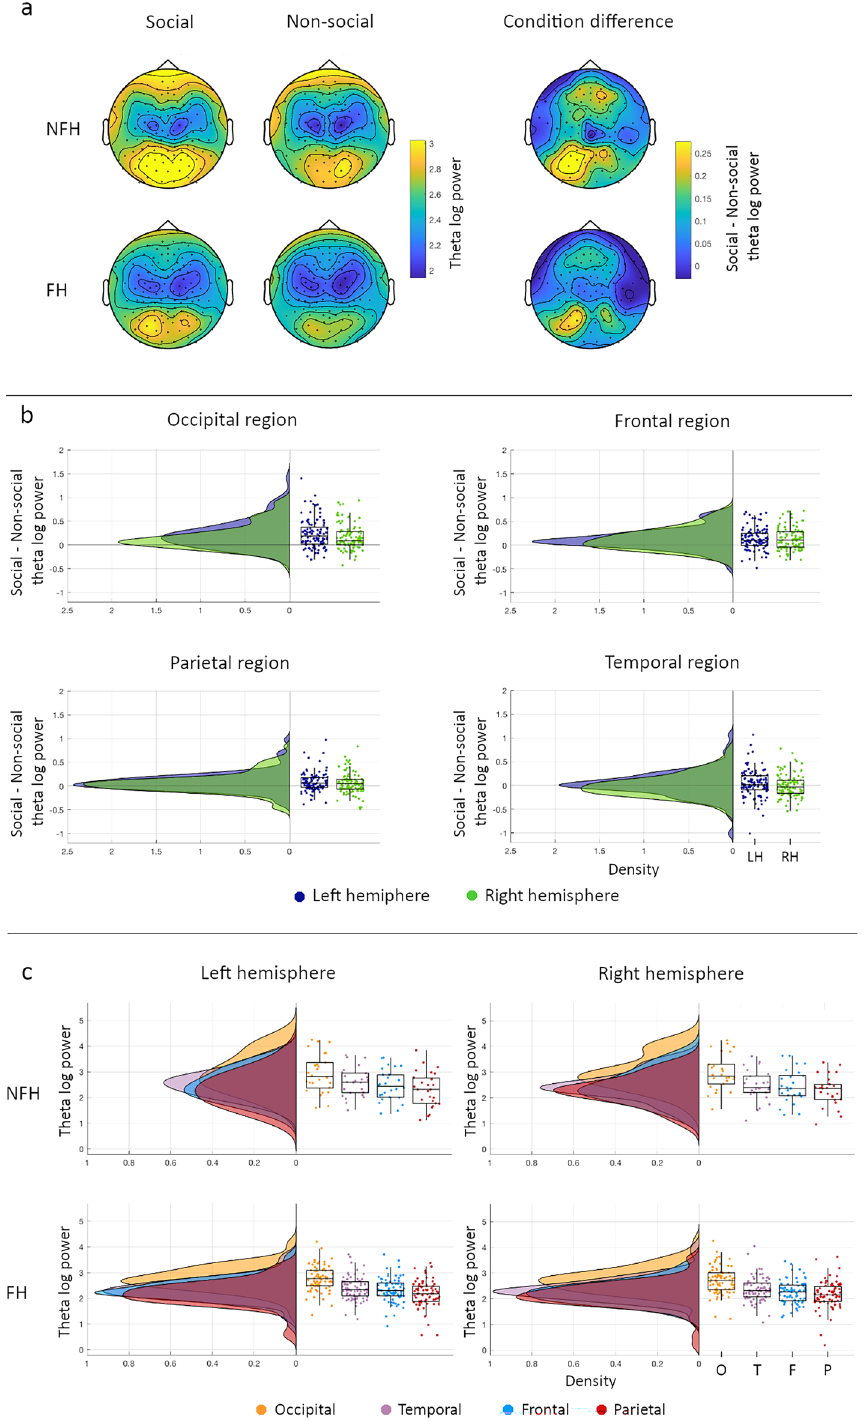
Figure 2. Theta power modulations by social context. ( a ) Topoplots for the social and non-social condition (left and middle) and the difference (social–non-social) between conditions (right) for the NFH (top) and FH (bottom) group. ( b ) Density and boxplots for condition differences in power for the left (LH in navy) and right (RH in green) hemisphere in for each region (occipital in top left, frontal in top right, parietal in bottom left, and temporal in bottom right plot). Each dot represents 1 infant. Positive values indicate higher power for social than the non-social condition. ( c ) Density and boxplots for power within each region (occipital (O) in yellow, Temporal (T) in purple, Frontal (F) in blue, and Parietal (P) in red) within the left hemisphere (left) and the right hemisphere (right) for the NFH (top) and the FH (bottom) group. Each dot represents 1